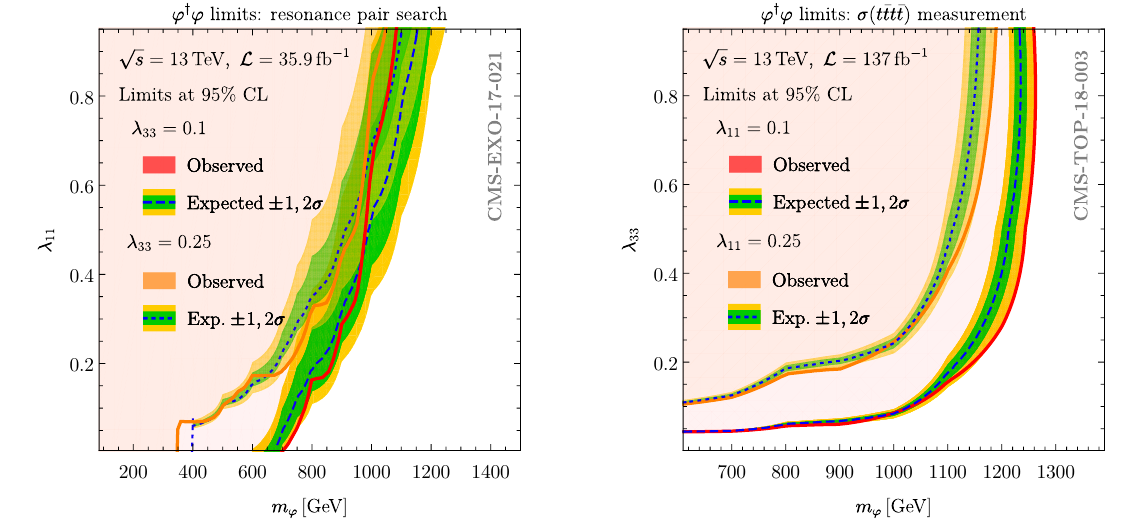
Figure 4 . Limits on sextet scalar pair production from (left) CMS-EXO-17-021 and (right) CMS- TOP-18-003. Left panel shows limits on λ 11 via σ ( pp → ϕ † ϕ → uu ¯ u ¯ u ) for two fixed values of λ 33 ; right panel displays the opposite via σ ( pp → ϕ † ϕ → tt ¯ t ¯ t )